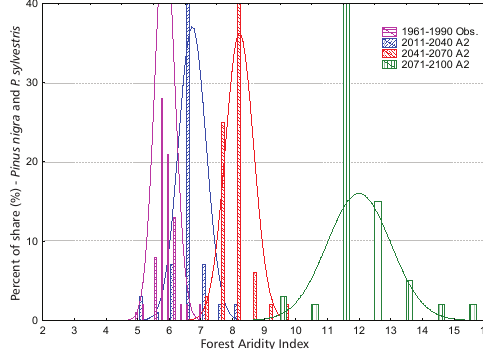
FIGURE 7. Distribution of Black and Scots pines across FAI categories in four climate